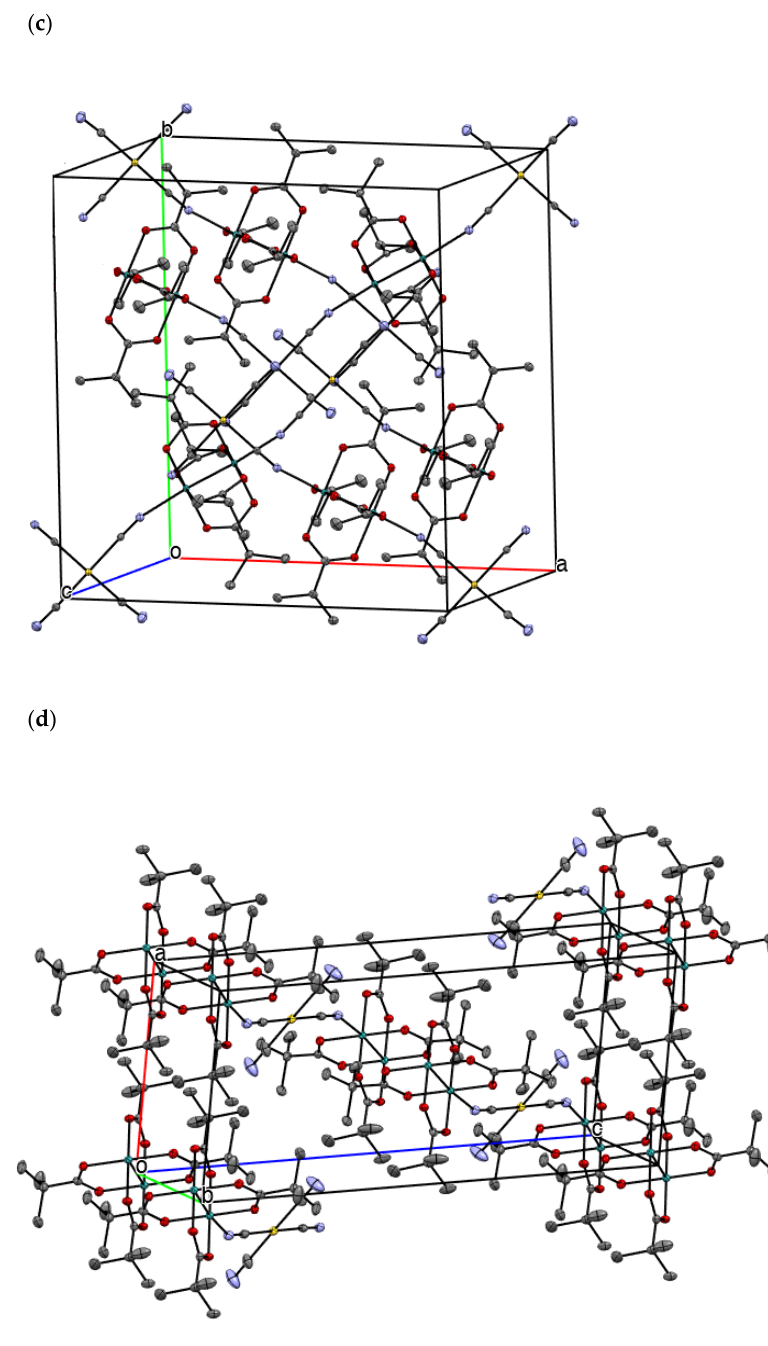
Figure 4. Packing diagrams of ( a ) [Ru 2 (CH 3 COO) 4 Au(CN) 4 ] n ( 1 ), ( b ) [Ru 2 (C 2 H 5 COO) 4 Au(CN) 4 ] n ( 2 ), ( c ) [Ru 2 ( i -C 3 H 7 COO) 4 Au(CN) 4 ] n ( 3 ), and ( d ) [Ru 2 ( t -C 4 H 9 COO) 4 Au(CN) 4 ] n ( 4 ). The hydrogen atoms have been omitted for clarity.